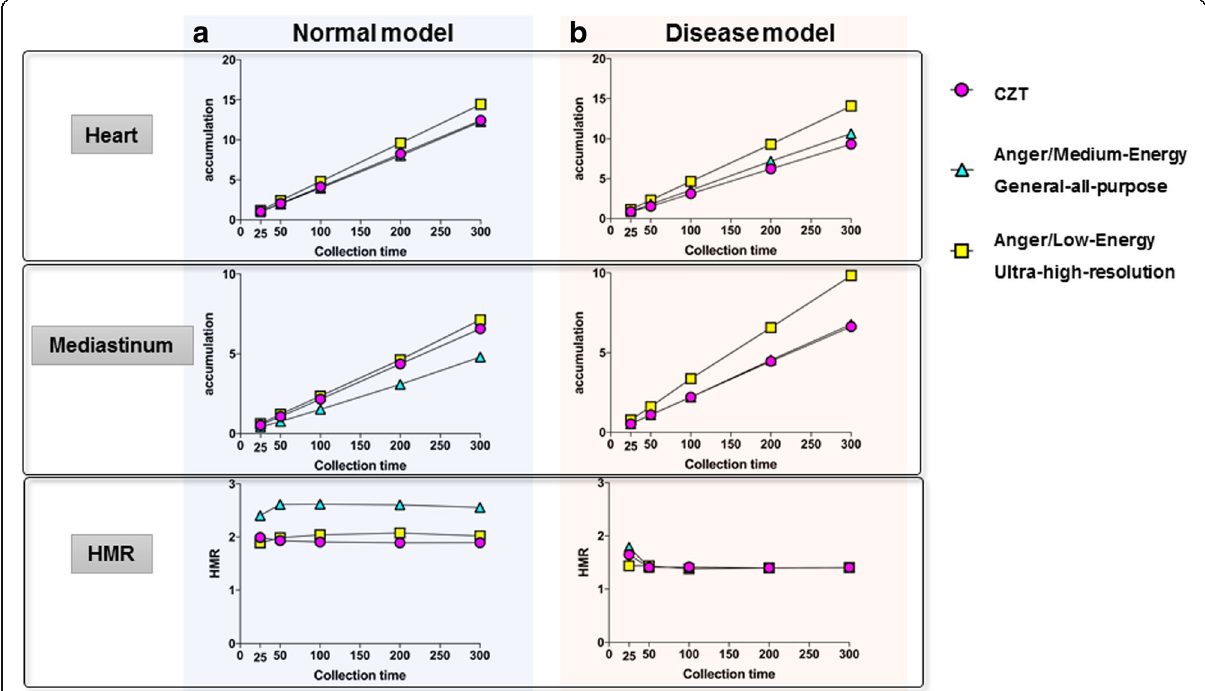
Fig. 4 Comparison between CZT-based and Anger cameras (phantom study). The relationship between different collection times ( x -axis) and radioactive counts in the ROIs on the heart (upper graphs) and mediastinum (middle graphs), and HMR (lower graphs) in the normal ( a ) and disease ( b ) models using three types of cameras. Pink circle — CZT-based camera, light blue triangle — Anger cameras with MEGAP collimators, yellow square — Anger cameras with LEUHR